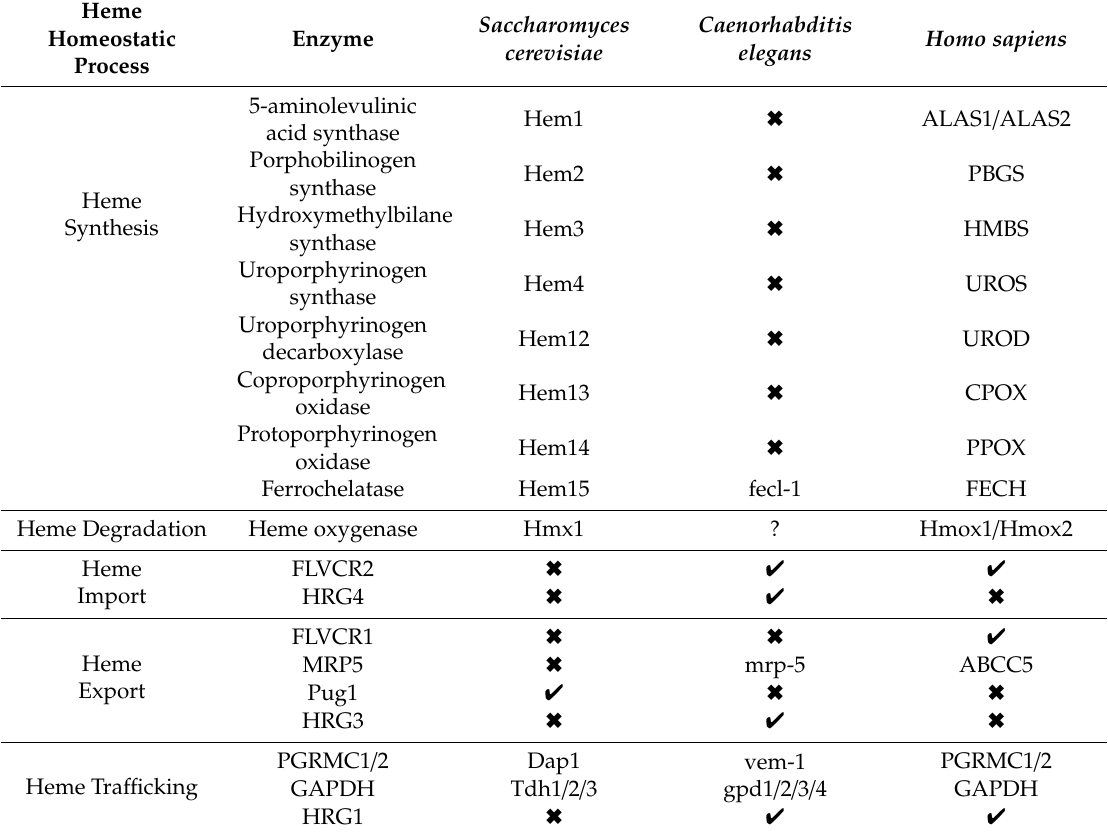
Table 1. Conservation of heme homeostatic factors between yeast, worm and